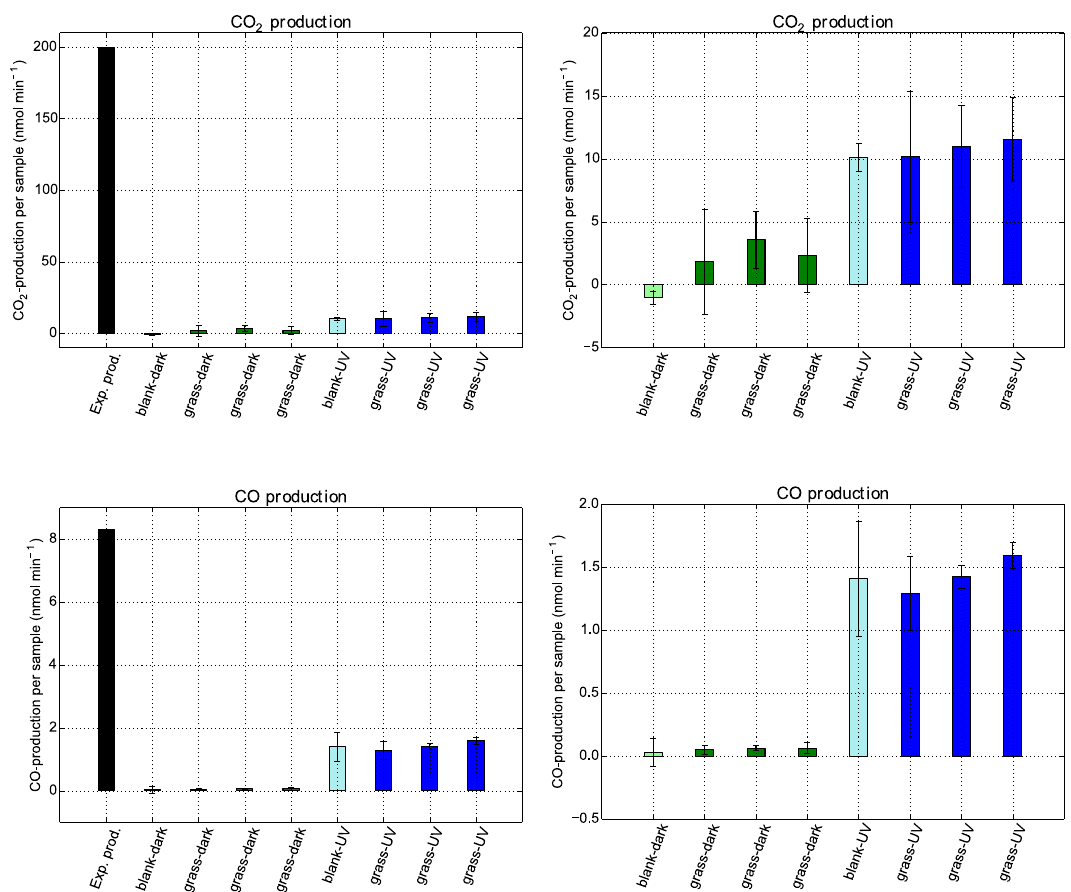
Figure B2. Results of photodegradation laboratory experiment. Results are for 2 gram samples, placed in a 33cm 2 cylinder. Upper figures: CO 2 production under different treatments. Exp. prod. stands for expected production based on comparison to Rutledge (2010). Right figure is zoom-in of left figure. Lower figures: CO production under different treatments. Exp. prod. stands for expected production based on comparison to Schade (1999). Right figure is zoom-in of left